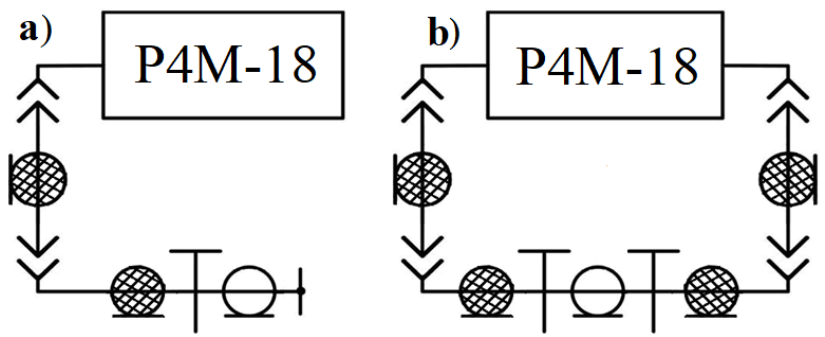
Fig. 2. Block chart of the me asurement setup, “reflection” ( a) and “transmission” scheme